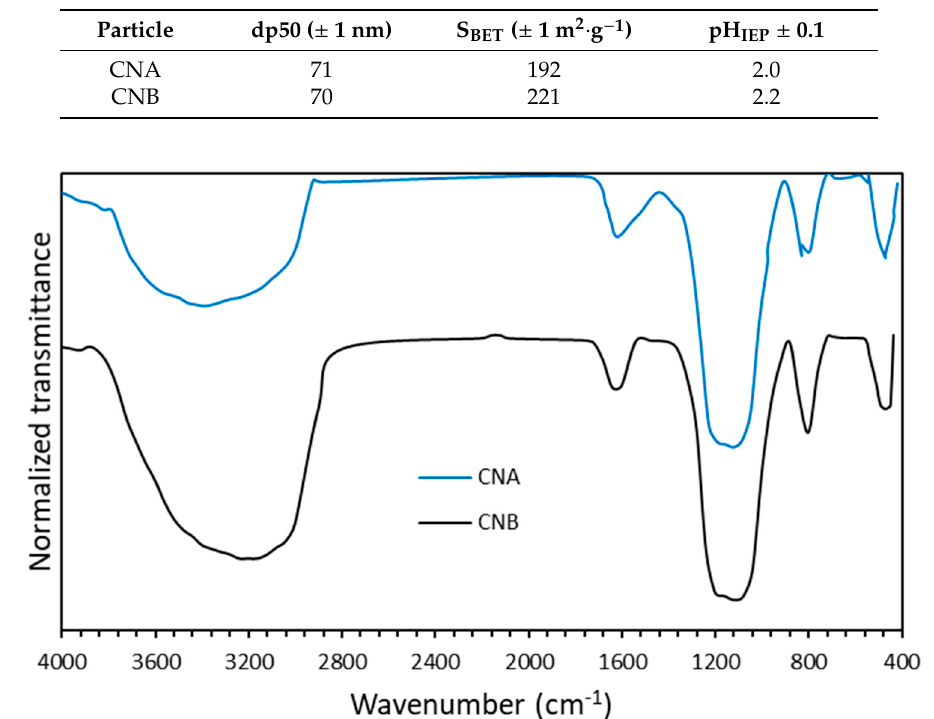
Figure 5. FTIR spectra obtained for the two types of commercial nanoparticles (CNA and CNB).